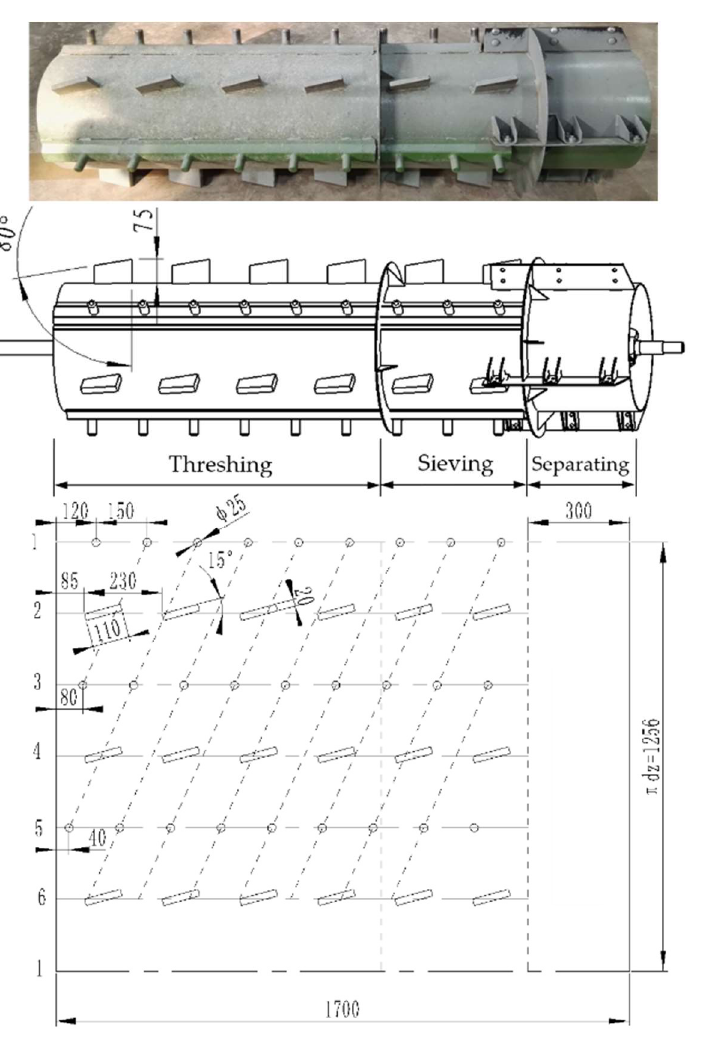
Figure 3. Transverse axial flow drum structure and the column tooth-plate’s tooth arrangement (magnified view).